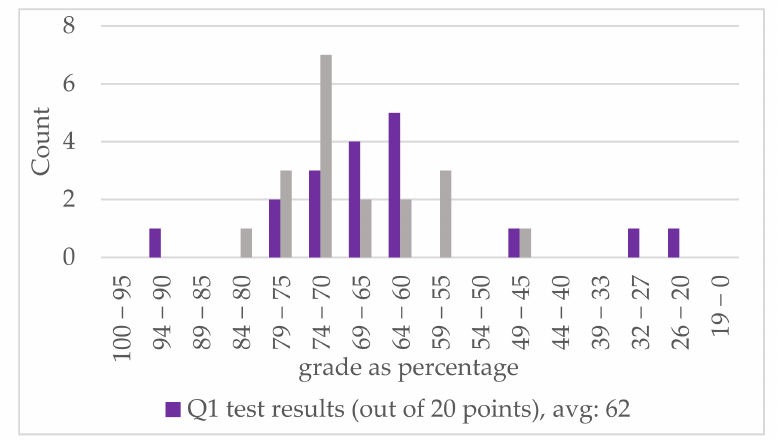
Figure 21. Comparison of the grades of the Q1 class between the evaluation results and the written grades they achieved in the same semester.